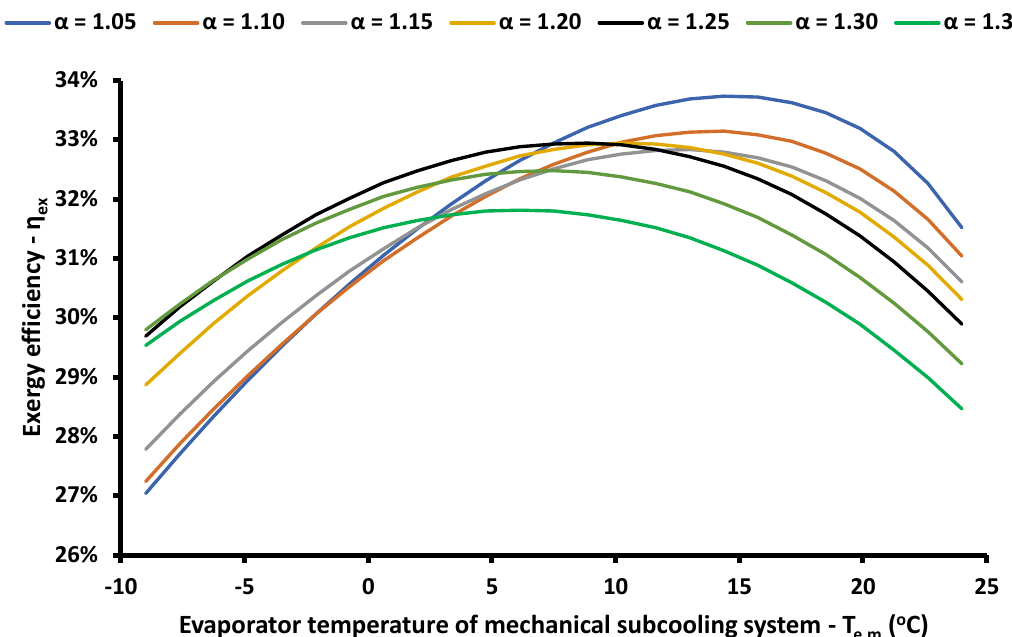
Figure 10. The exergy e ffi ciency of the mechanical subcooling system for di ff erent values of the evaporator temperature and di ff erent pressure ratio parameters (T e = − 15 ◦ C and T c = 40 ◦